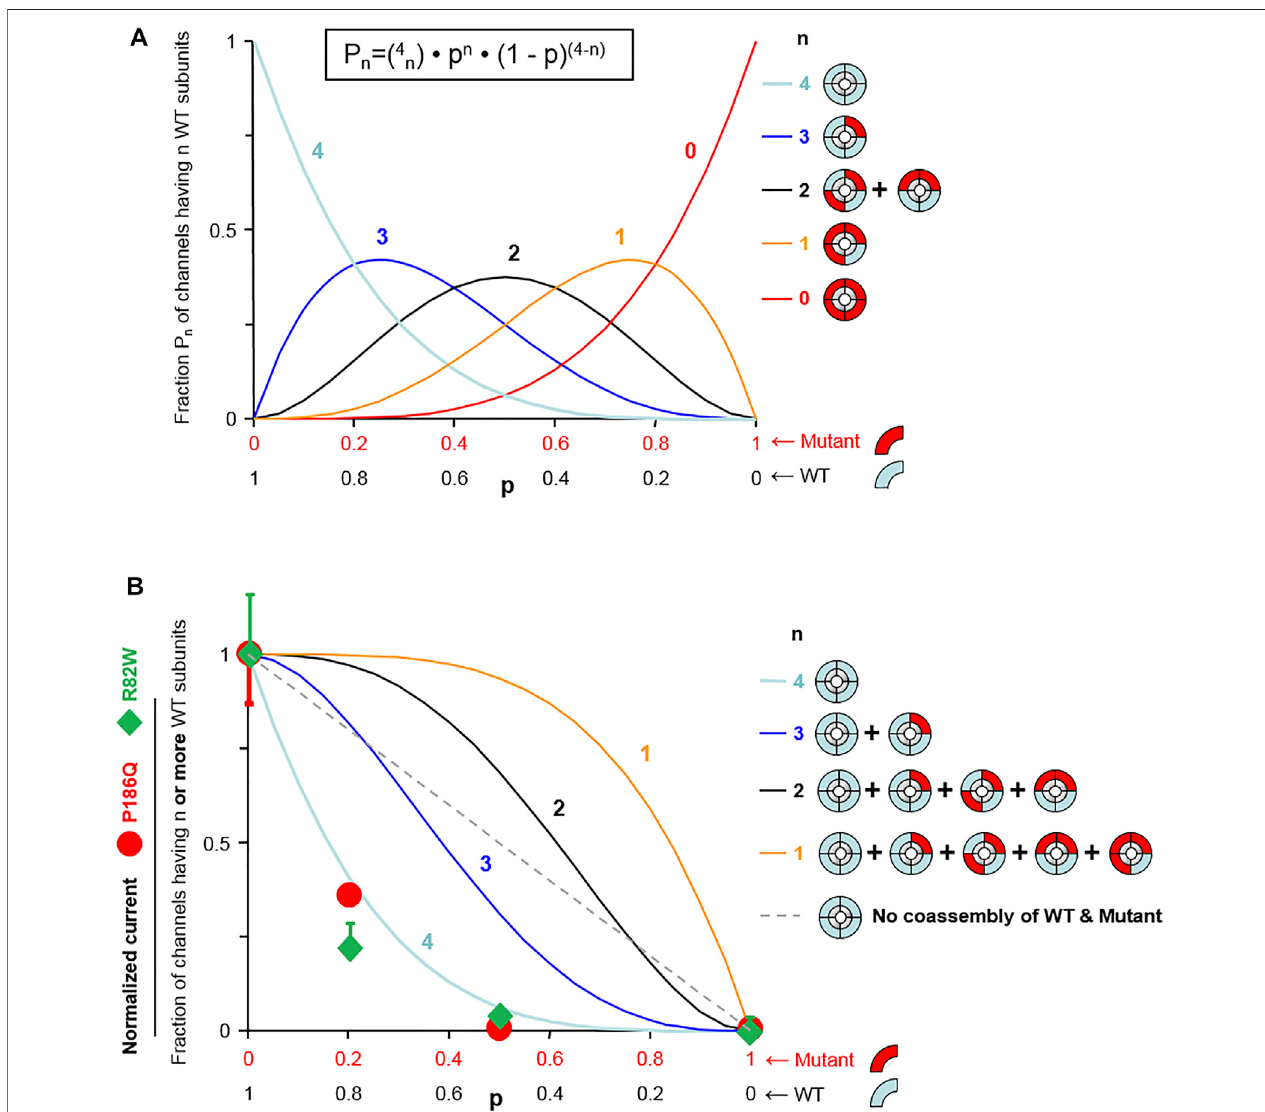
FIGURE3| Model fi ttingrevealsthatonemutantsubunitissuf fi cienttoimpairthefunctionofKir2.1tetramericchannels. (A) AssumingrandomassemblyofWTand mutantsubunits,theprobabilityofoccurrenceofchannelshavingexactlynWTsubunits(P n )followsabinomialdistribution (equationshown attop).ThatprobabilityP n is shown as a function of the fraction of wild-type subunits (p) for each possible value of n (n indicated next to the curves). (B) Probability of a channel having n or more WT subunits calculated using the distributions of (A) (n indicated next to the curves). The straight dotted line represents the probability of a WT channel if WT subunits and mutant subunitscouldnotco-assemble.Thesymbols represent normalizedK + current. Thepercent deviationoftheexperimental datafromeach model, calculated fromthermsd(rootmean-squaredeviation)isforp.Pro186Gln:3.6%( n (cid:1) 4),28%( n ≥ 3),46%( n ≥ 2),56%( n ≥ 1),and33%(noWT/mutantmixing;dottedstraightline); and for R82W:9.4% ( n (cid:1) 4), 33% ( n ≥ 3), 49% ( n ≥ 2), 59% ( n ≥ 1), and 37% (no WT/mutant mixing; dotted straight line). Forboth mutants, the experimental data match best the model n (cid:1) 4, meaning that channels are fully functional only when they contain no mutant subunits.